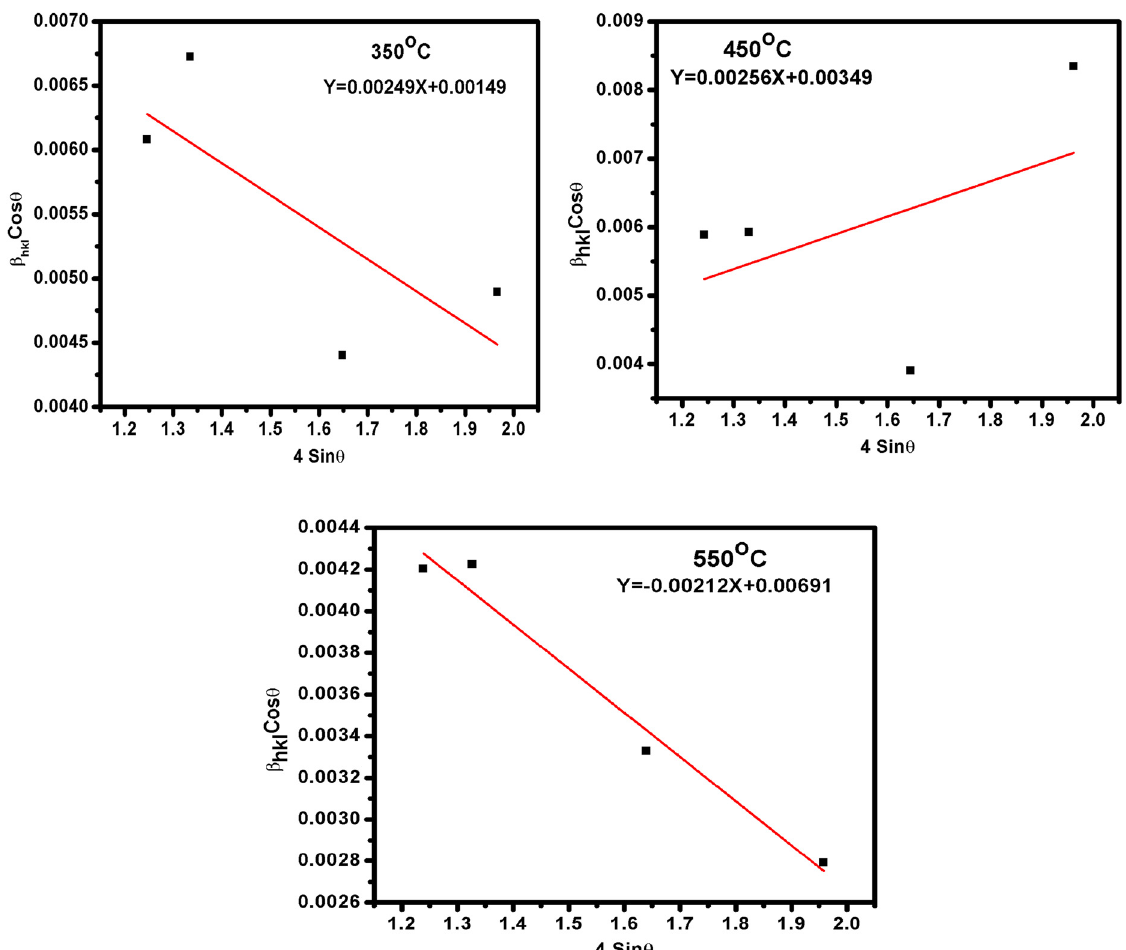
Figure 2: Williamson – Hall plots of CuO samples calcinated at calcination temperatures of 350, 450, and 550°C.